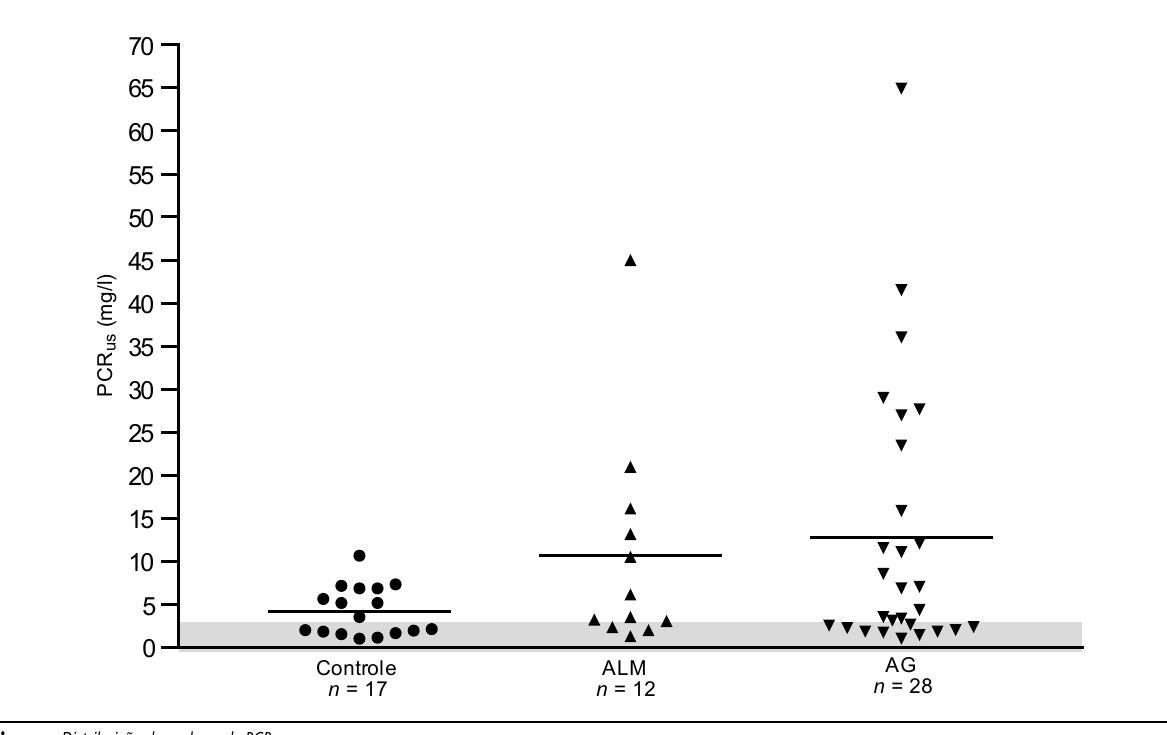
Figura – Distribuição dos valores de